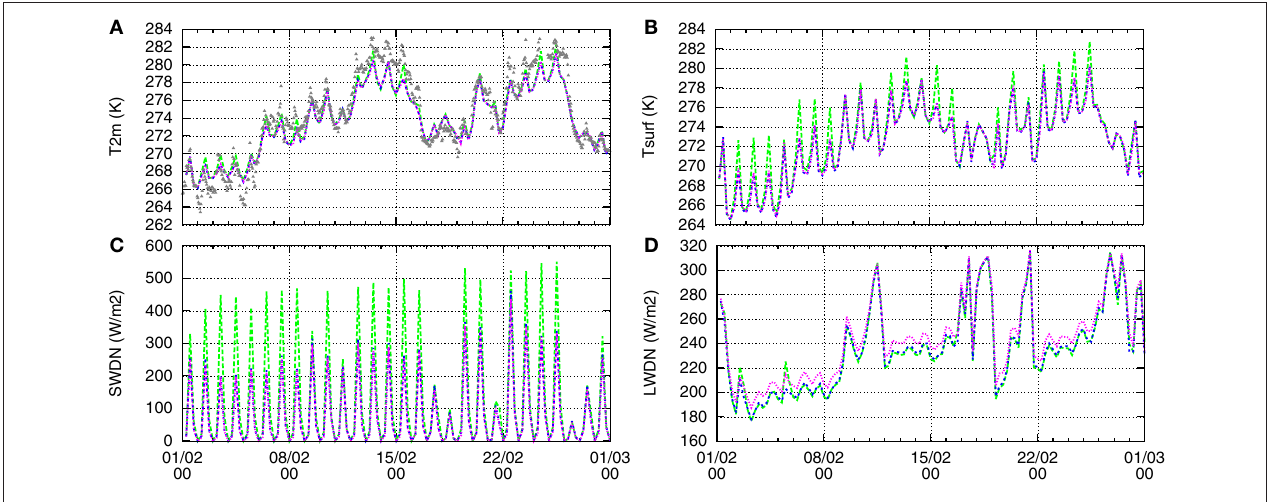
FIGURE 11 | As in Figure 10 but at Olympic mountain station 11. Note the different scales on